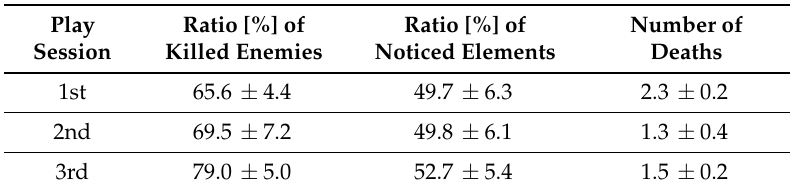
Table 1. Results per play session (ratios represented as percentages), provided as STD ± STE, where STD stands for standard deviation and STE for standard error of the mean.